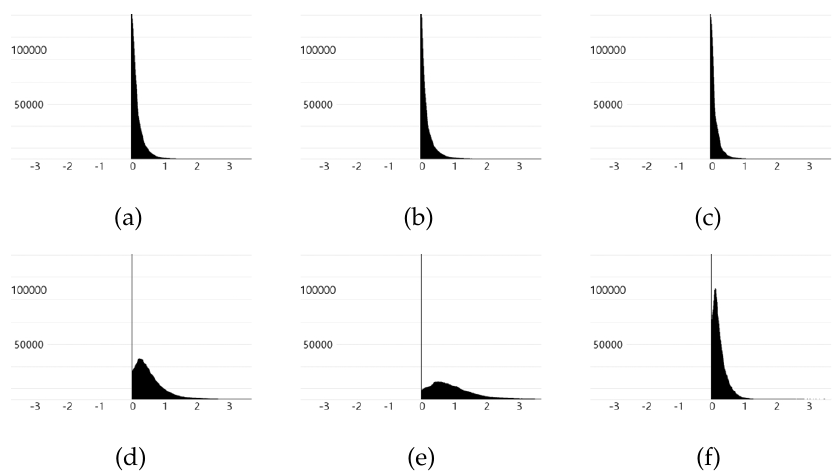
Figure 4. Comparison of the distribution as a histogram for data generated after ReLU in L 6 , L 11 and L 16 layers. ( a ) VDSR ( L 6 ), µ = 0.09, σ = 0.04. ( b ) VDSR ( L 11 ), µ = 0.08, σ = 0.05. ( c ) VDSR ( L 16 ), µ = 0.05, σ = 0.02. ( d ) Proposed method ( L 6 ), µ = 0.27, σ = 0.26. ( e ) Proposed method ( L 11 ), µ = 0.35, σ = 0.46. ( f ) Proposed method ( L 16 ), µ = 0.12, σ =